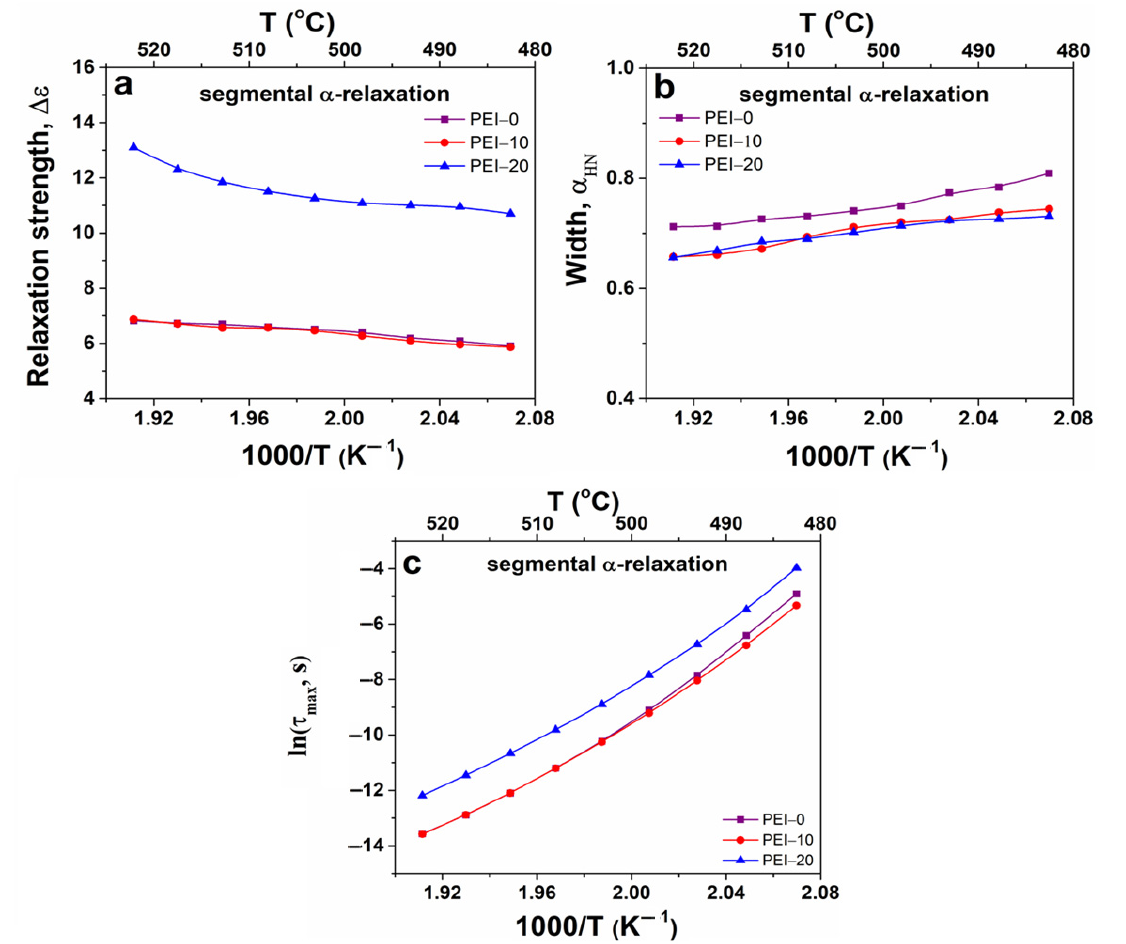
Figure 7. Reciprocal temperature dependences of the relaxation strength ( a ), width ( b ), ln( τ max ) ( c ) parameter for the VFT fitted α -relaxation of the neat PEI and the nanocomposites with 10 wt% and 20 wt% cobalt ferrite fractions. Table 3. Parameters of the VFT equation for the segmental α -relaxation.